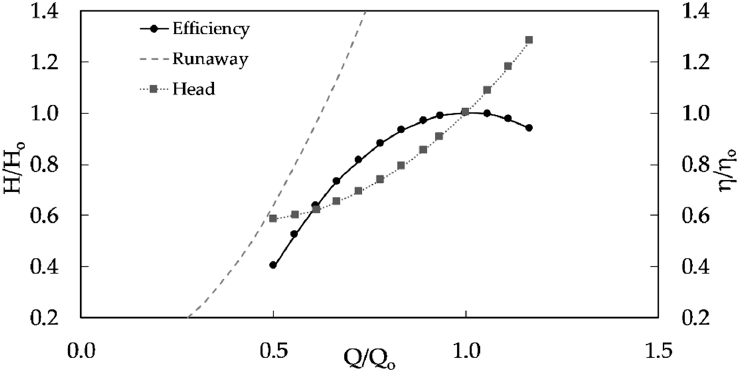
Figure 13. Dimensionless turbine characteristic curves based on numerical simulations.